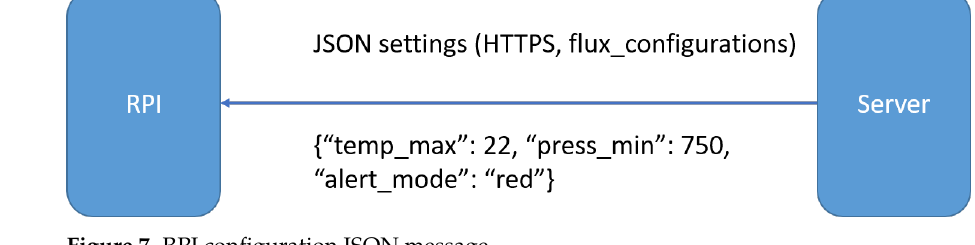
Figure 7. RPI configuration JSON